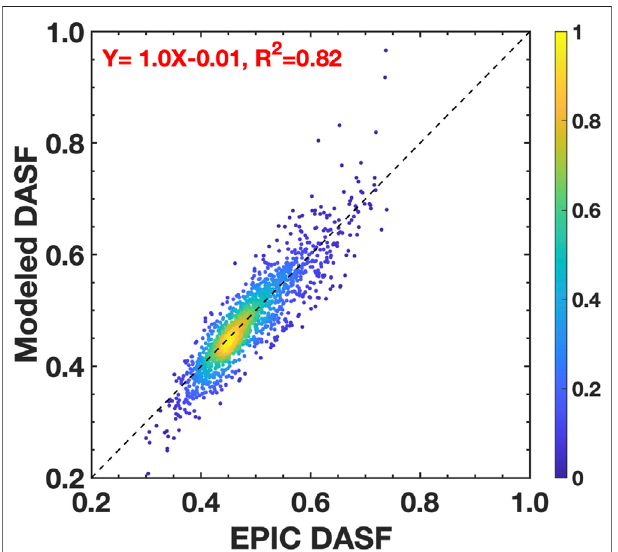
FIGURE 9 | Correlation between diurnal courses of modeled and EPIC DASFs accumulated over Amazonian, Congo forests and region 3.2 in southeast Asia during the 2017 to 2019 period. Data from December to February over Congo forests are excluded. NRMSE (cid:2) 7%. The relationship between these data is characterized by a regression line with a slope of 1 and negligible intercept; R 2 (cid:2) 0.82.